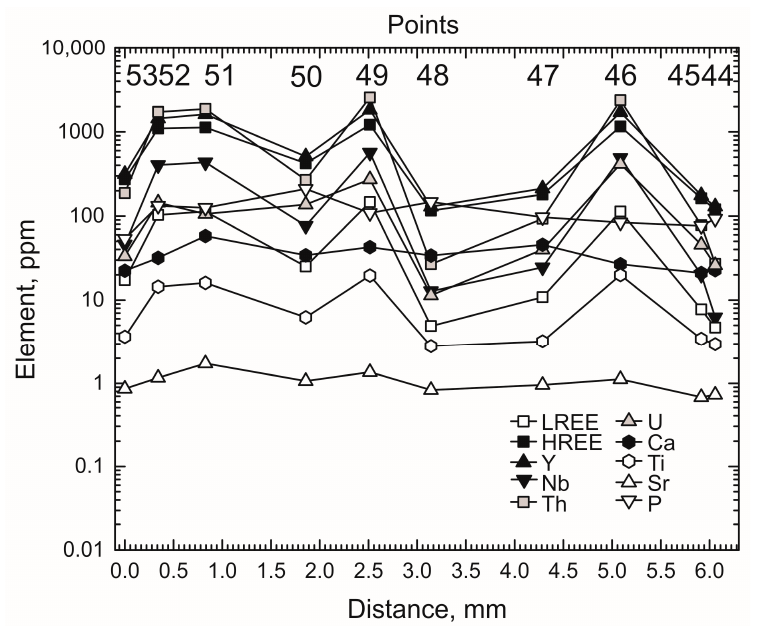
Figure 12. Trace elements zoning of zircon in the growth sector of the face (111) of the